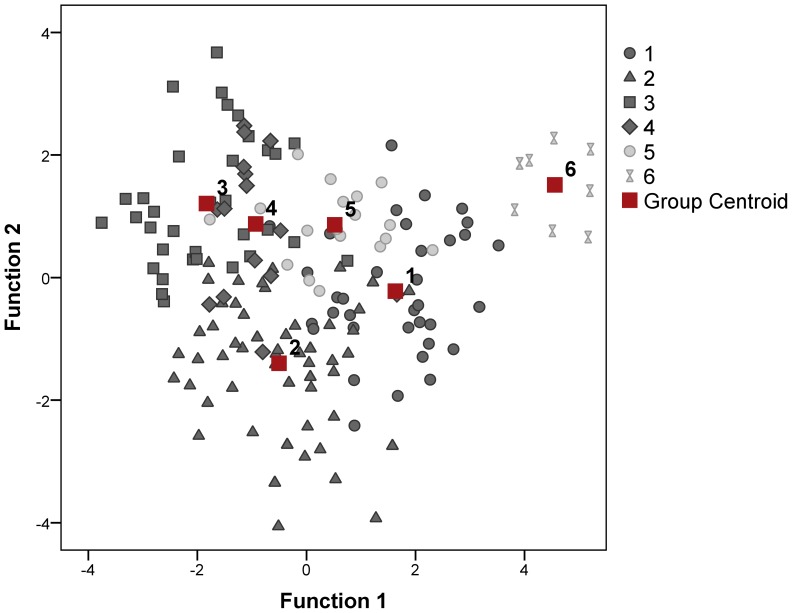
Vocal individuality in pant calls of northern white rhinos recorded in various social contexts.The plot shows the first two canonical discriminant functions with the centroid values of pant calls for each animal. 1 = Fatu, 2 = Nabiré, 3 = Nájin, 4 = Nesárí, 5 = Súdán, 6 = Suni.